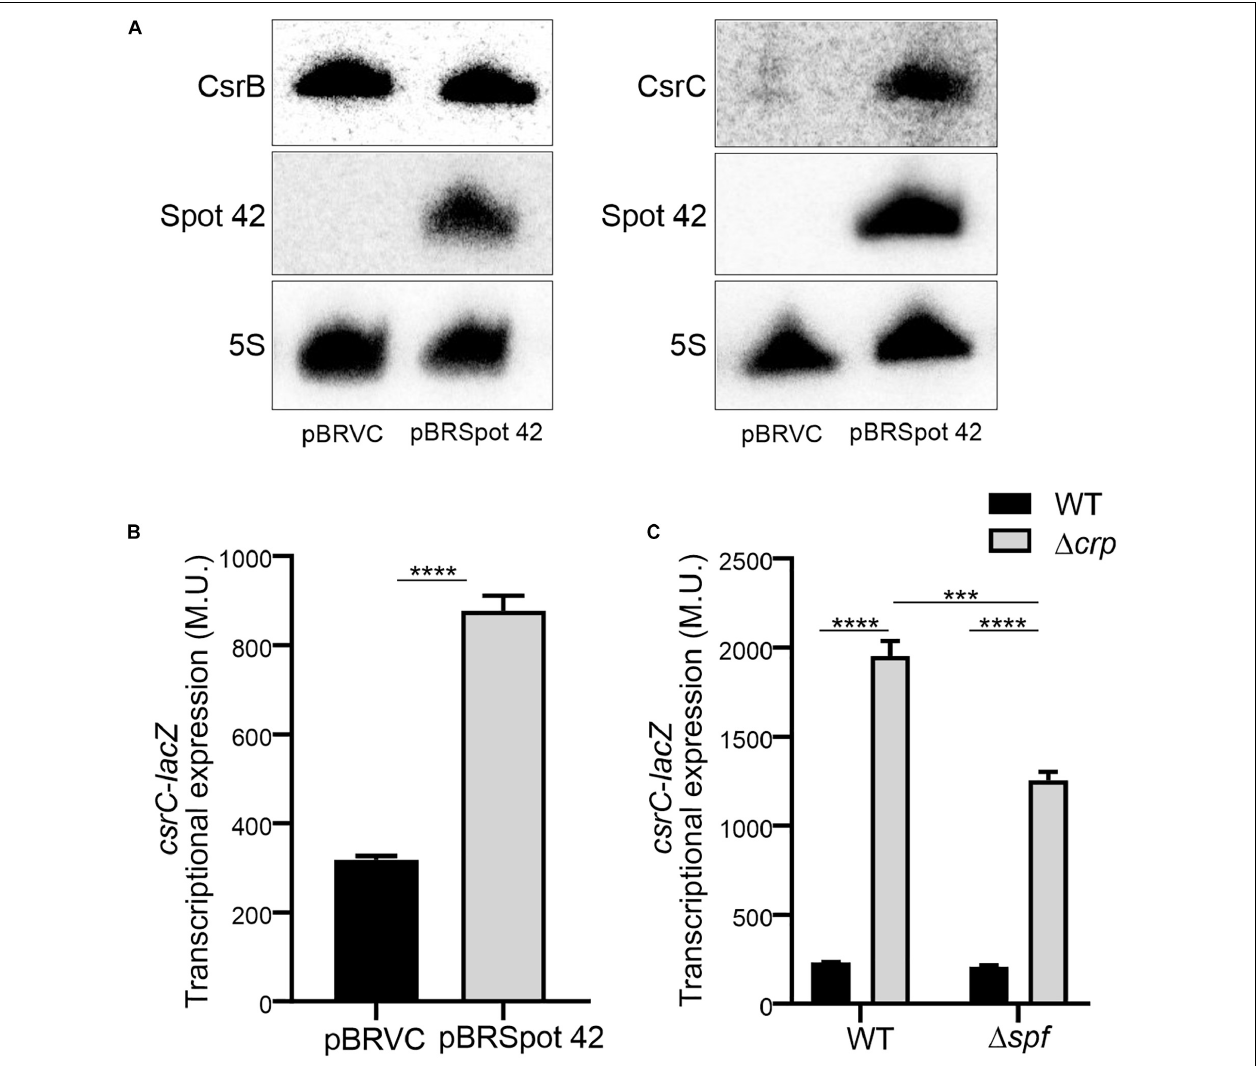
FIGURE 4 | Spot 42 positively regulates the expression of CsrC. (A) Northern blot detection of CsrB, CsrC, and Spot 42 was carried out in strains carrying either the pBRplacVC (control) or pBRplac Spot 42 (overexpressing the sRNA Spot 42). 5S RNA was monitored as loading control. (B) Transcriptional expression of the chromosomal csrC - lacZ fusion upon ectopic expression of the sRNA Spot 42 compared to the strain carrying the control vector (pBRplacVC). (C) Transcriptional expression of the chromosomal csrC-lacZ fusion was monitored in WT, (cid:49) spf , (cid:49) crp, and (cid:49) spf (cid:49) crp genetic backgrounds. In all cases cultures were grown in LB at 37 ◦ C up to an OD 600 nm of 0.4. β -galactosidase activity was determined for three independent cultures, average and standard deviation is presented. **** p < 0.0001, *** p <